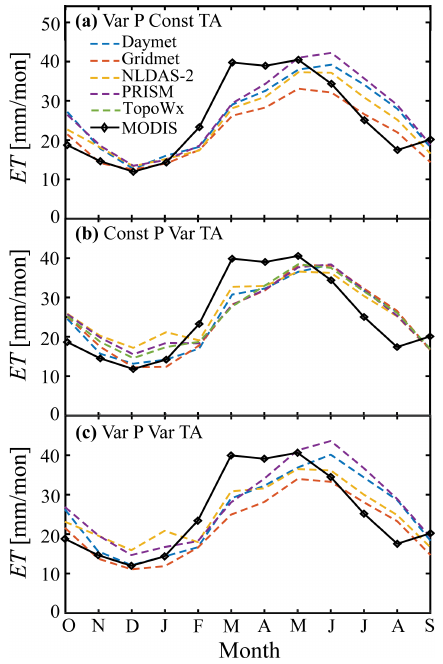
Figure 5. Monthly ET in WY2016 from the MODIS remote sens- ing product (solid lines) as well as the range of simulated ET from each of the three experiments (a) VarPConstTA, (b) ConstPVarTA, and (c) VarPVarTA (dashed lines) in the Kaweah River watershed. Croplands are removed from this comparison as irrigation is not in- cluded in